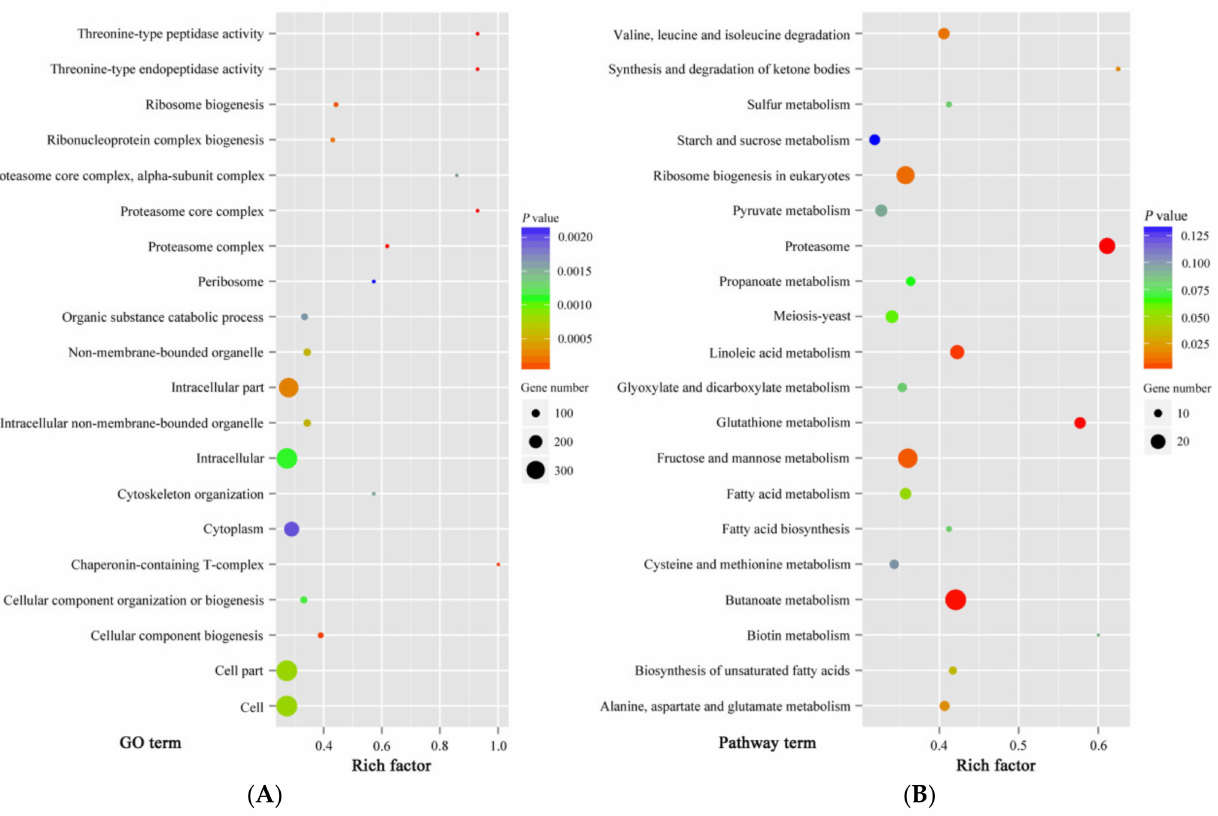
Figure 4. Scatter plots of the top 20 Gene Ontology (GO) ( A ) and Kyoto Encyclopedia of Genes and Genomes (KEGG) ( B ) enrichment of differentially expressed proteins (DEPs) in P. expansum spores under 0.25 mg L − 1 cinnamon oil stress after 6 h of culture. The deeper color in the color code represents the highest confidence of the biological process. Rich factor: the number of DEPs in one GO or KEGG/the number of total identified proteins in the same GO or KEGG. A higher value indicates a higher enrichment level. The size of dot represents the number of DEPs. A larger dot indicates more